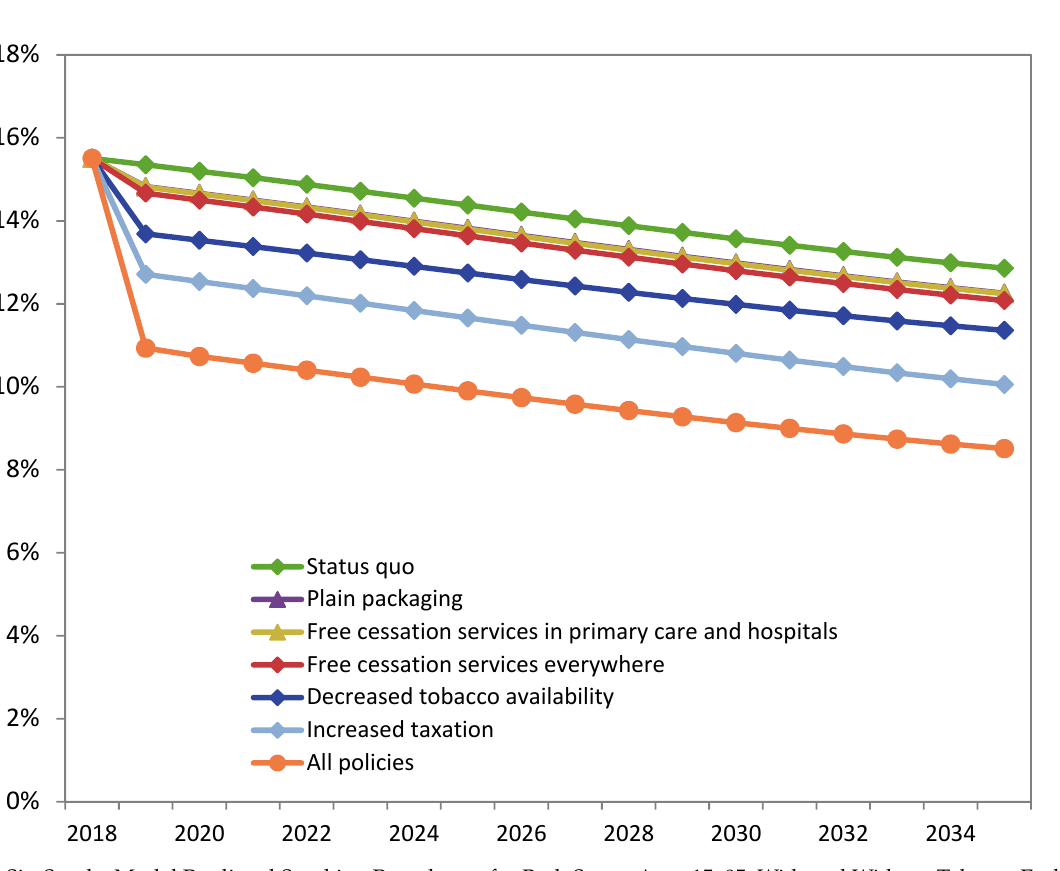
Figure 1. SimSmoke Model Predicted Smoking Prevalence, for Both Sexes, Ages 15–85, With and Without Tobacco Endgame Policies, Ontario, 2018–2035. Status quo represents the policy levels prior to the first projection year (2019). Note: Full data table for this graph provided in the Appendix A (Table A1) Source: Ontario SimSmoke.